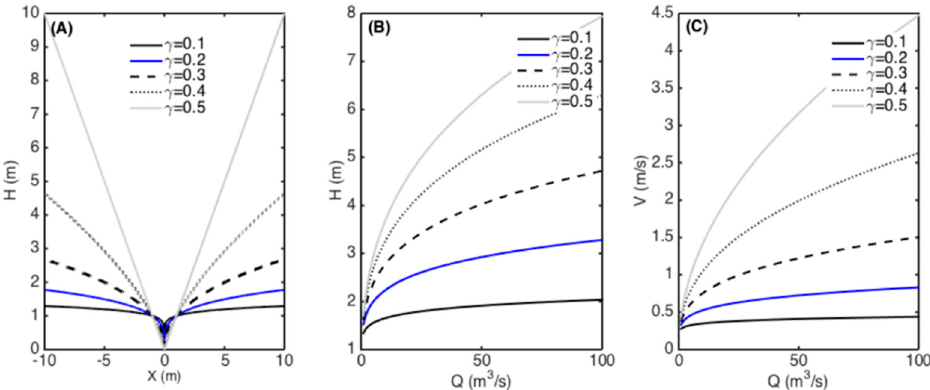
Figure 1. Example of different cross-sections described with different values of γ ( A ), the corresponding flow rating curve ( B ) and the velocity as a function of the discharge ( C ). Parameter a and parameter b are defined on the basis of the assigned value of γ , while the remaining parameters are a = 2 γ , b = 1 and c = 0.2.